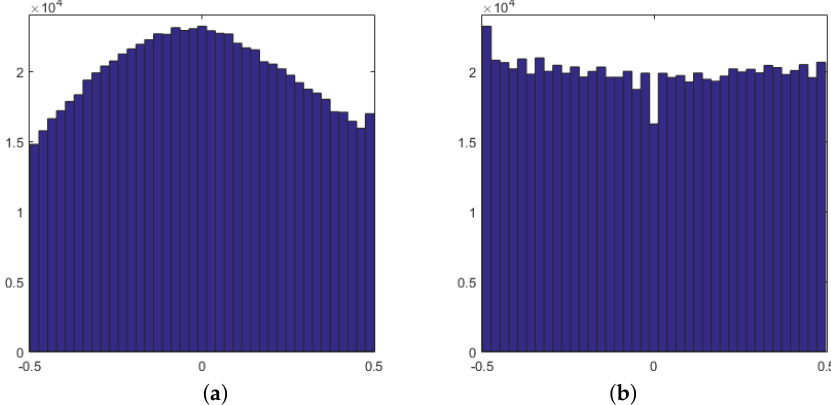
Figure 11. Subpixel distribution ( a ) based on the parabola interpolation [61] and ( b ) after our proposed